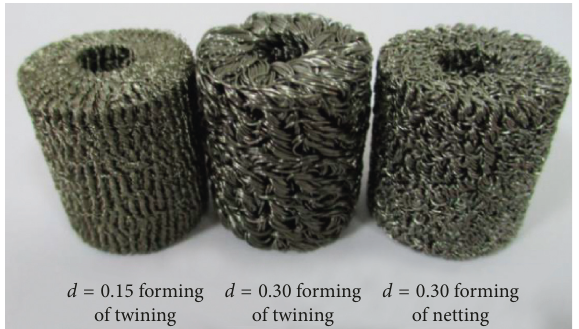
Figure 15: MR with different weaving process parameters.